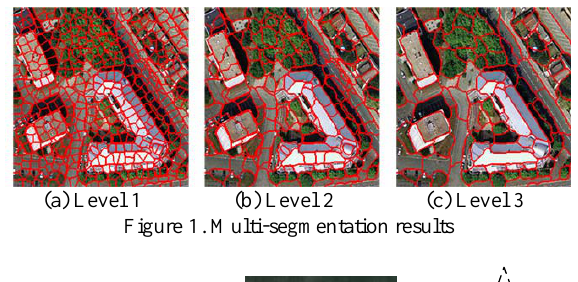
Figure 1. Multi-segmentation results